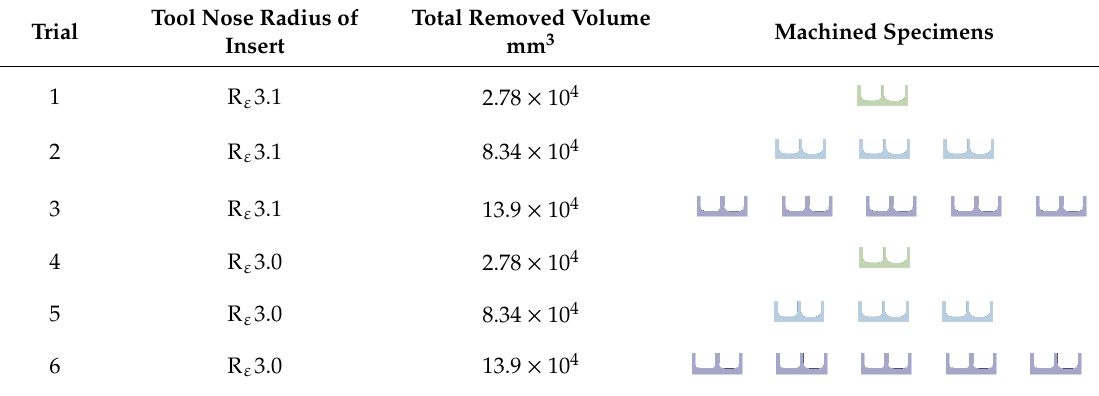
Table 4. Design of experiments.